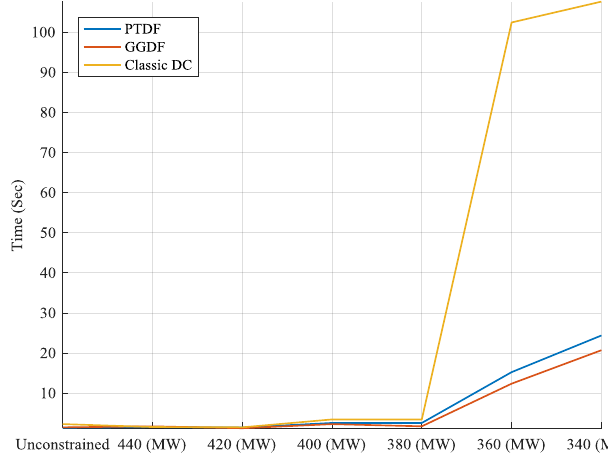
Figure 4. Average run times of TCUC with different transmission network limits.